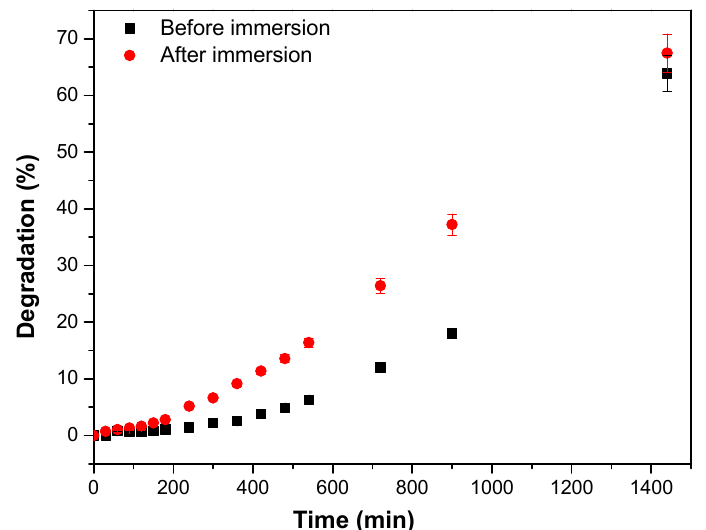
Figure 10. Wettability of PBAT/PLA fibers incorporated with TiO 2 -R/Fe 3 O 4 (10:1%) in the degrada- tion of the dye Reactive Red 195.